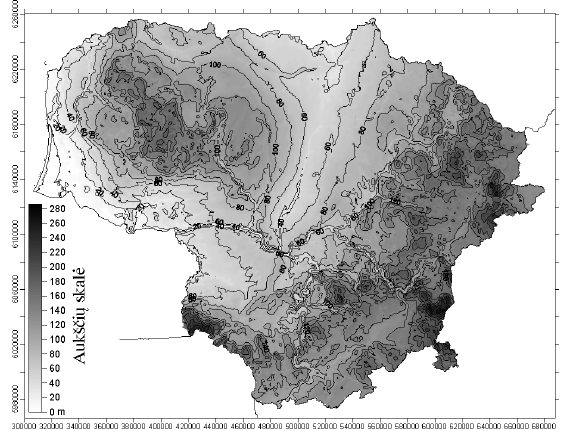
Fig 1. Relief of Lithuania (digital terrain model) 2. Duomenys ir metodika